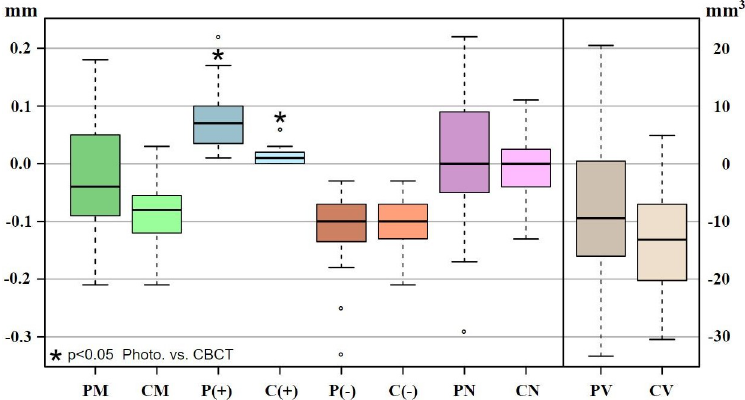
Fig 8. Box-and-whisker plot of results of matching process, with list of abbreviations. Group 1: PAT vs. μ -CT (white); group 2: CBCT vs. μ -CT (blue). Surface and volume deviations for PAT compared with μ -CT, and for CBCT compared with μ -CT. Mandibular incisors were scanned using μ -CT, CBCT, and PAT. Individual three-dimensional models were created. μ -CT images were defined as the reference standard. CBCT and PAT images were compared with μ -CT images. The root surface and volume deviations between PAT and μ -CT, and between CBCT and μ -CT are displayed. � = significant difference between PAT and CBCT. The results for the comparison of PAT with μ -CT had a slightly larger range than the results for the comparison of CBCT with μ -CT. PM : Total average of the deviation of the RSA (PAT compared with μ -CT) , CM : Total average of the deviation of the RSA (CBCT compared with μ -CT), P (+) : Positive deviation of the RSA (PAT compared with μ -CT), C (+) : Positive deviation of the RSA (CBCT compared with μ -CT), P ( − ) : Negative deviation of the RSA (PAT compared with μ -CT), C ( − ) : Negative deviation of the RSA (CBCT compared with μ -CT), PN : Normalized total average of the deviation of the RSA (PAT compared with μ -CT), CN : Normalized total average of the deviation of the RSA (CBCT compared with μ -CT), PV : Volume deviation of the RSA (PAT compared with μ -CT), CV : Volume deviation of the RSA (CBCT compared with μ -CT), SD : Standard deviation.